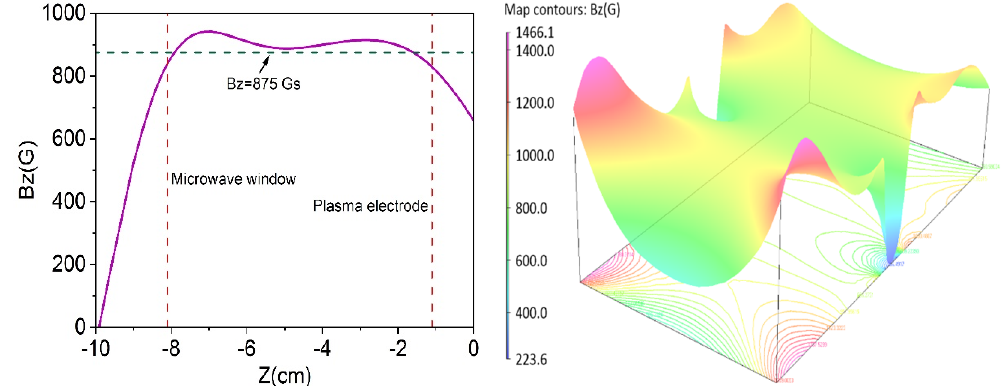
Figure 8. Calculated Bz along the axial direction and histogram in the midplane of the plasma chamber. The maximum extraction beam current under differing input microwave power is shown in Figure 9, when hydrogen was used as the working gas, the extraction voltage is 50 kV and the aperture of the plasma electrode is Ø6.5 mm. The maximum total extraction beam current is about 95 mA, and the corresponding microwave power is 900 W.